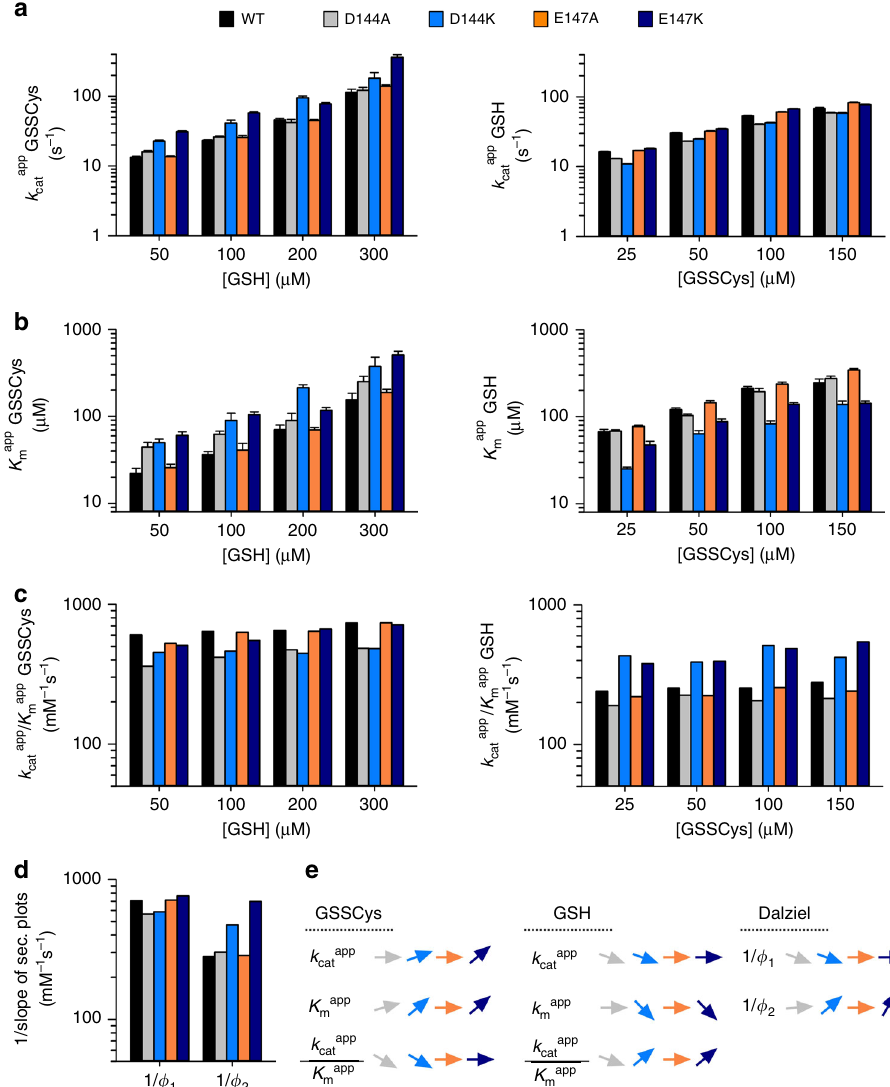
and K app cat m and K app values cat m